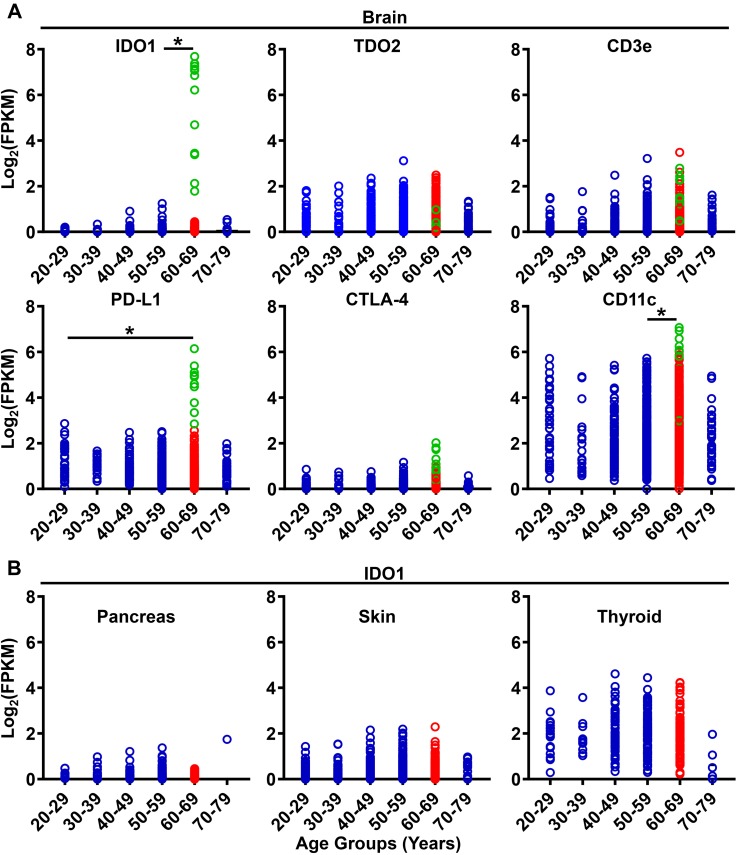
Gene expression for immunosuppressive and immunoregulatory factors increase in the normal human brain with aging. (A) GTEx gene expression analysis of IDO1, TDO2, CD3ε, PD-L1, CTLA-4, and CD11c in the brain. Data was analyzed among age groups including 20–29 (n = 38), 30–39 (n = 19), 40–49 (n = 123), 50–59 (n = 386), 60–69 (n = 549), 70–79 (n = 37). Green circles across gene panels share the same sample IDs. (B) GTEx gene expression analysis of IDO1 in the normal human pancreas (n = 167), skin (n = 812), and thyroid (n = 280). ∗P < 0.05.